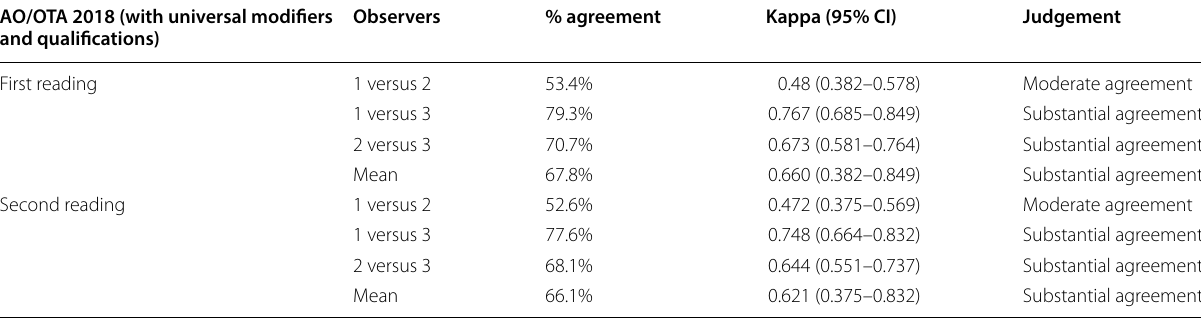
Table 4 Level of agreement among observers for the AO/OTA 2018 classification with the universal modifiers and qualifications after both review sessions